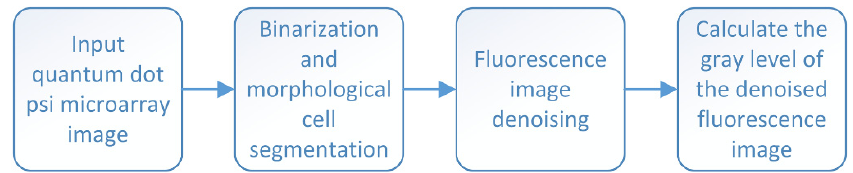
Figure 14. Flowchart of the real algorithm in the experiment.